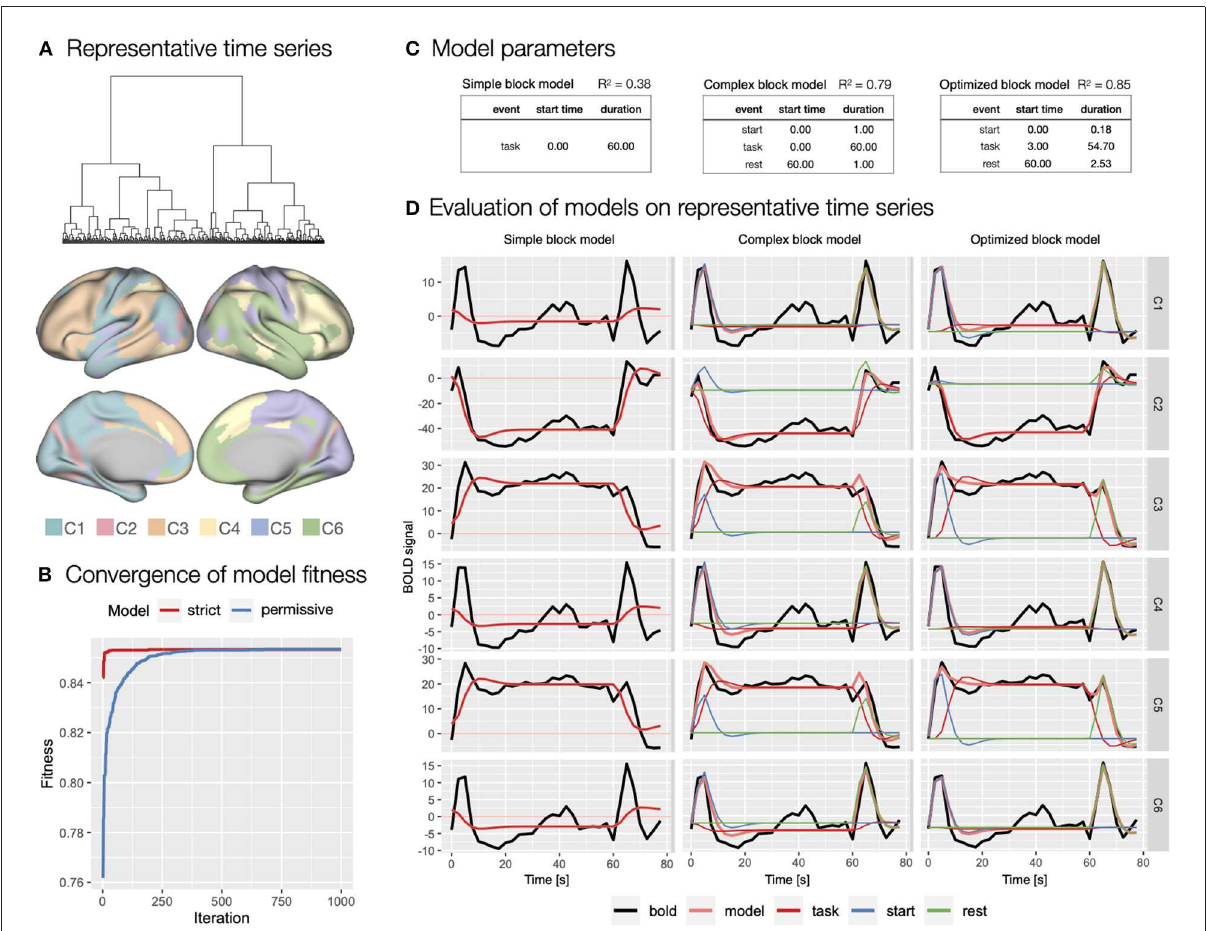
FIGURE7 Specification and evaluation of theoretical and automatically derived event models in the flanker study. (A) To optimize the evaluation of the event models and facilitate comparisons, we used hierarchical cluster analysis to identify six representative time series of task block responses. The panel shows the dendrogram of the cluster analysis and the distribution of the six identified clusters across cortical parcels. (B) Using autohrf we explored optimization of two event models that differed by predefined constraints: a strict model closer to theoretical assumptions and a more permissive model. We ran autohrf with a population of 100 for 1000 iterations. The plot was created using the plot_fitness function. (C) Model parameters for the three key event models explored. A theoretical model with a single task regressor for the entire block (simple block model), a theoretical model with regressors for block start, sustained task performance, and rest (complex block model) with a priori event durations, and an autohrf -optimized model with event onset and duration that yielded the best model fit (optimized block model). R 2 of each model is a weighted average over representative time series weighted by the number of parcels represented in each cluster. (D) Model fits over representative time series. BOLD time series are shown in black, time series predicted by the model in light red, while blue, red, and green show the contribution of block start , task , and rest events,